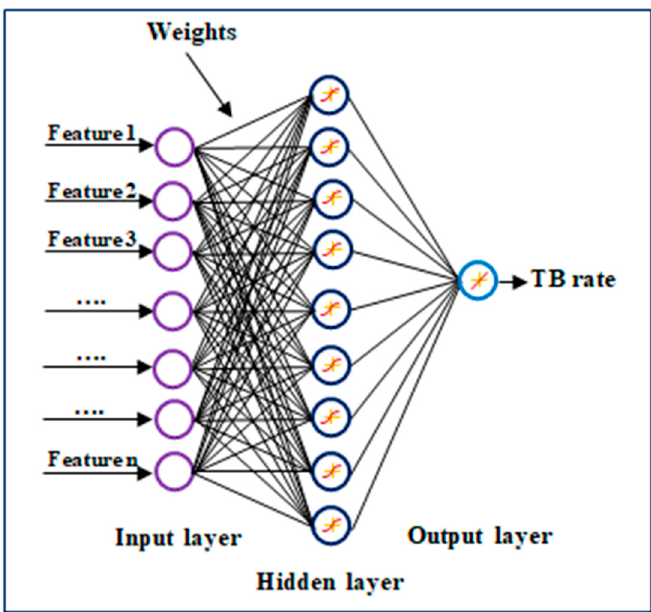
Figure 1. Topological architecture of multi-layer perceptron neural network (MLPNN) used in this study [63].